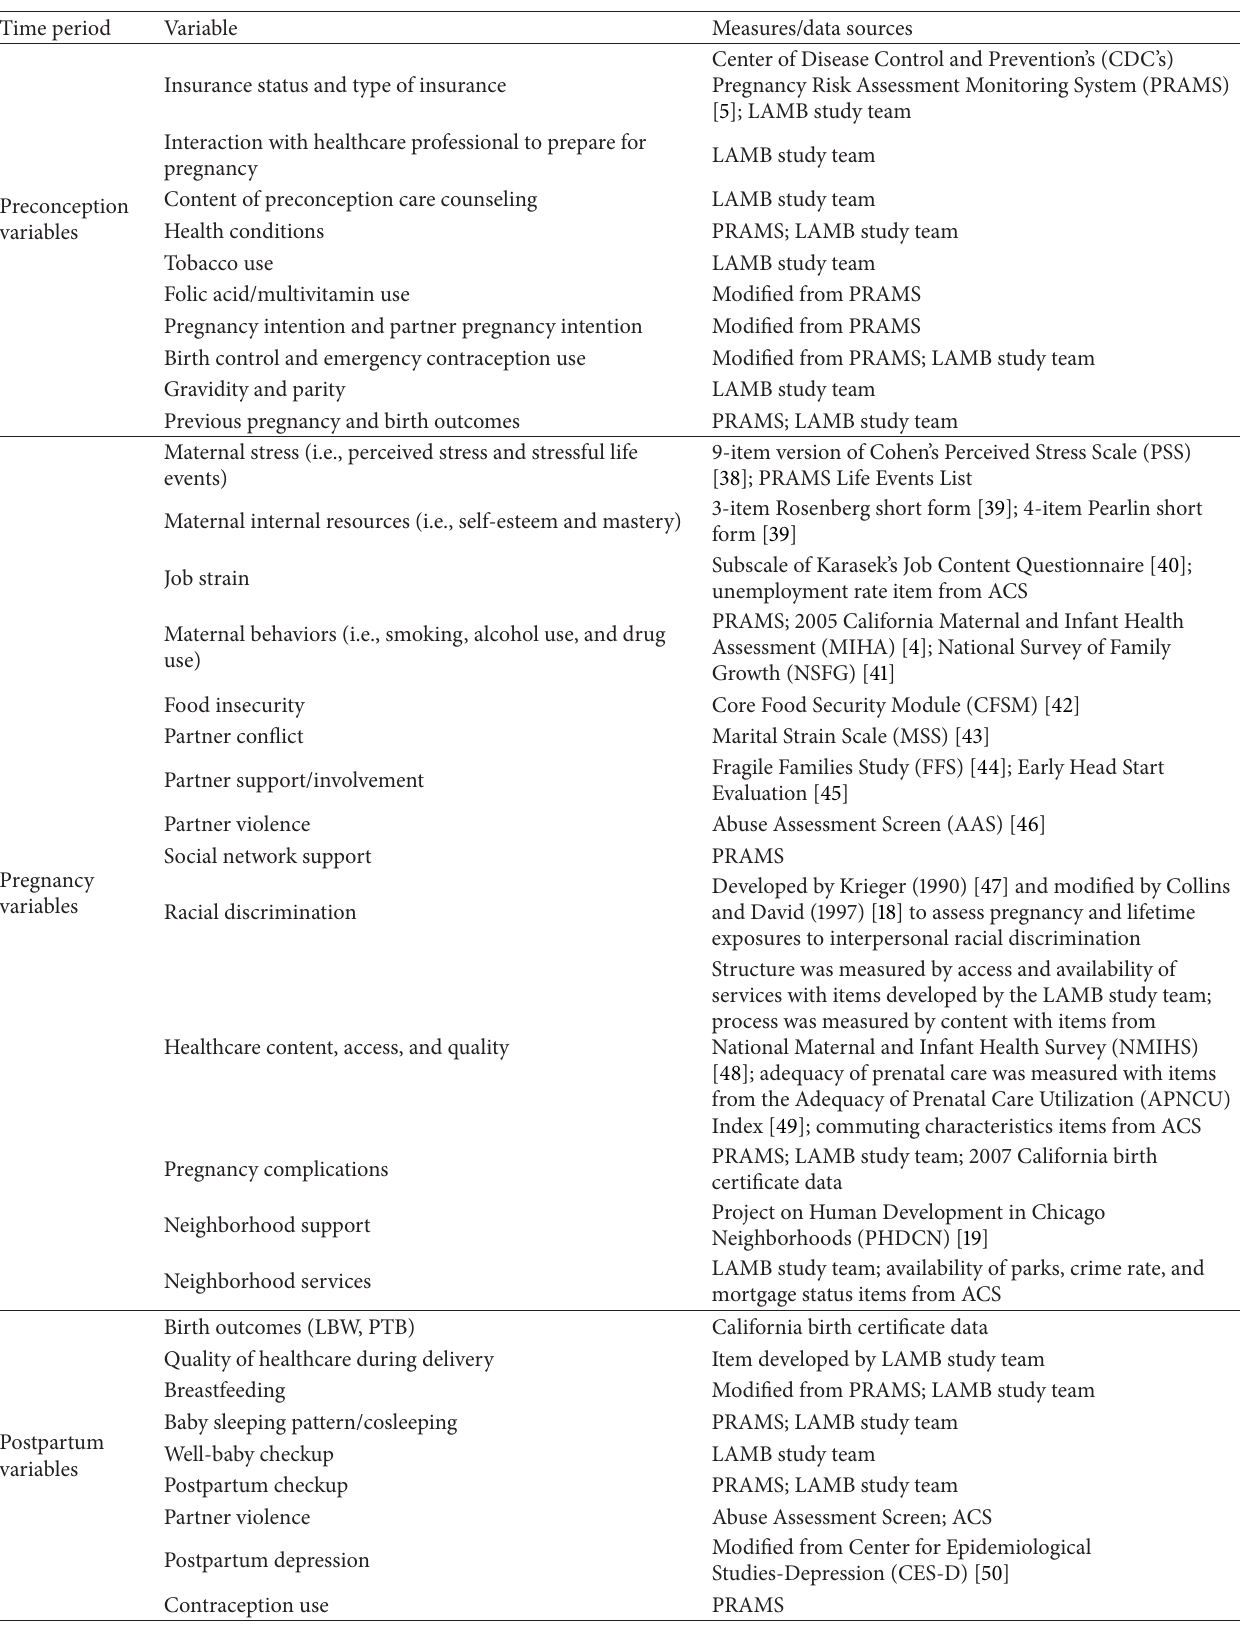
Table 1: Overview of key measures and data sources in 2007 LAMB